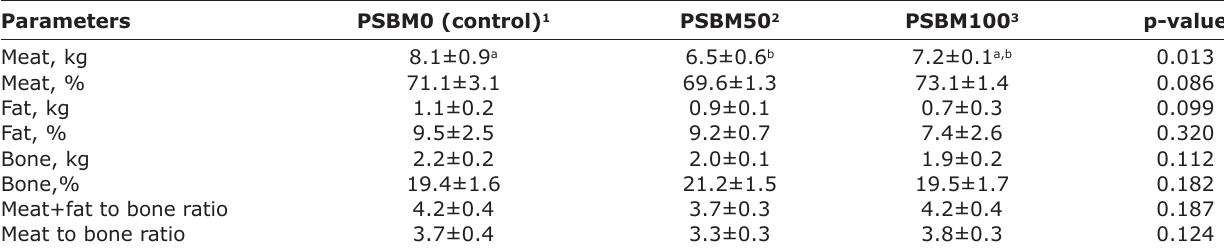
Table-2: Carcass components and meat to bone ratio. Parameters